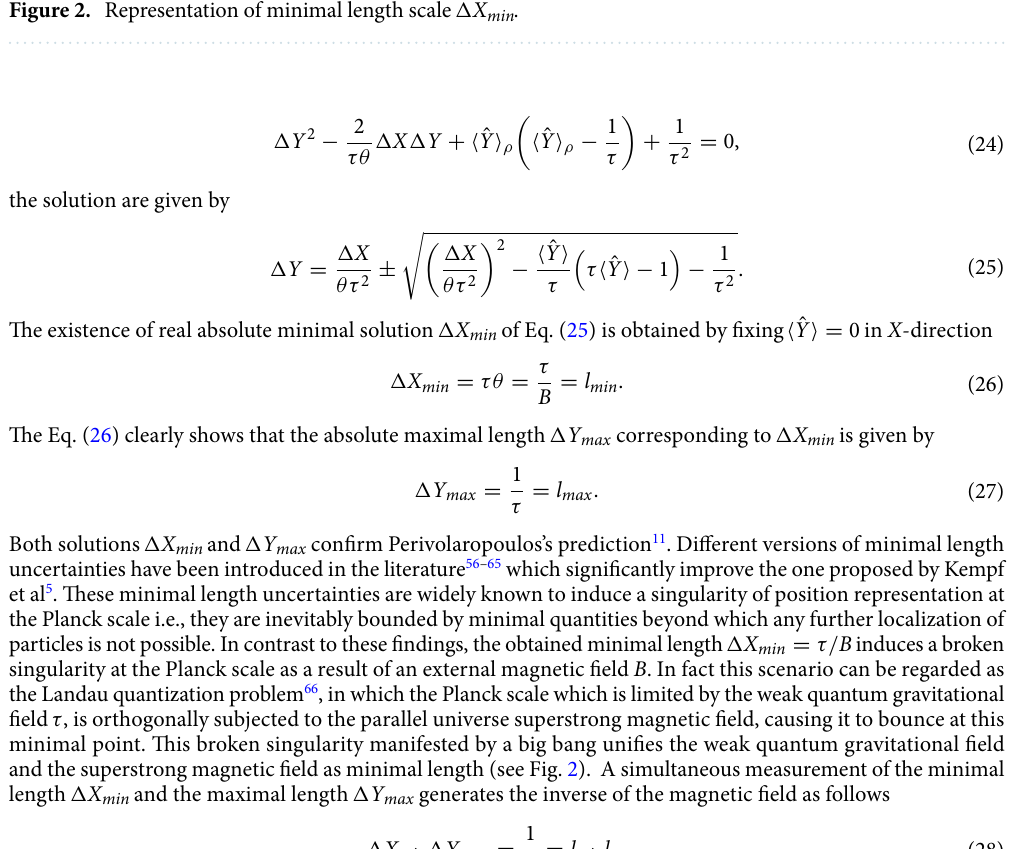
Figure 2. Representation of minimal length scale (cid:31) X min